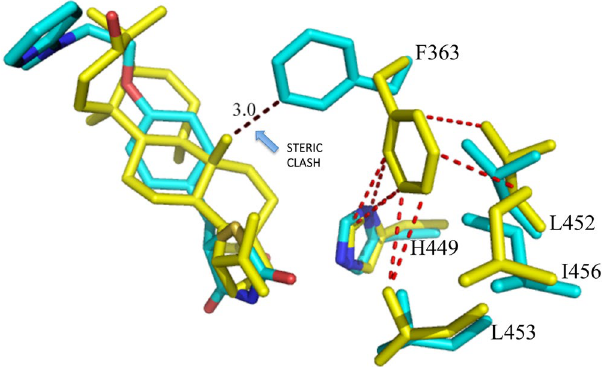
Figure 4. Superposition of PPAR γ /BA and PPAR γ /rosiglitazone complexes. Superposition of the crystal structures of the PPAR γ /BA (yellow) and PPAR γ /rosiglitazone (pdb code 2PRG) (cyan) complexes. The F363 side-chain in gauche conformation (cyan) would sterically clash (black dashed lines) with a methyl group of BA. The gauche * conformation of F363 allows vdW interactions (ranging from 3.3 to 3.7 Å) with hydrophobic residues on H11 (red dashed